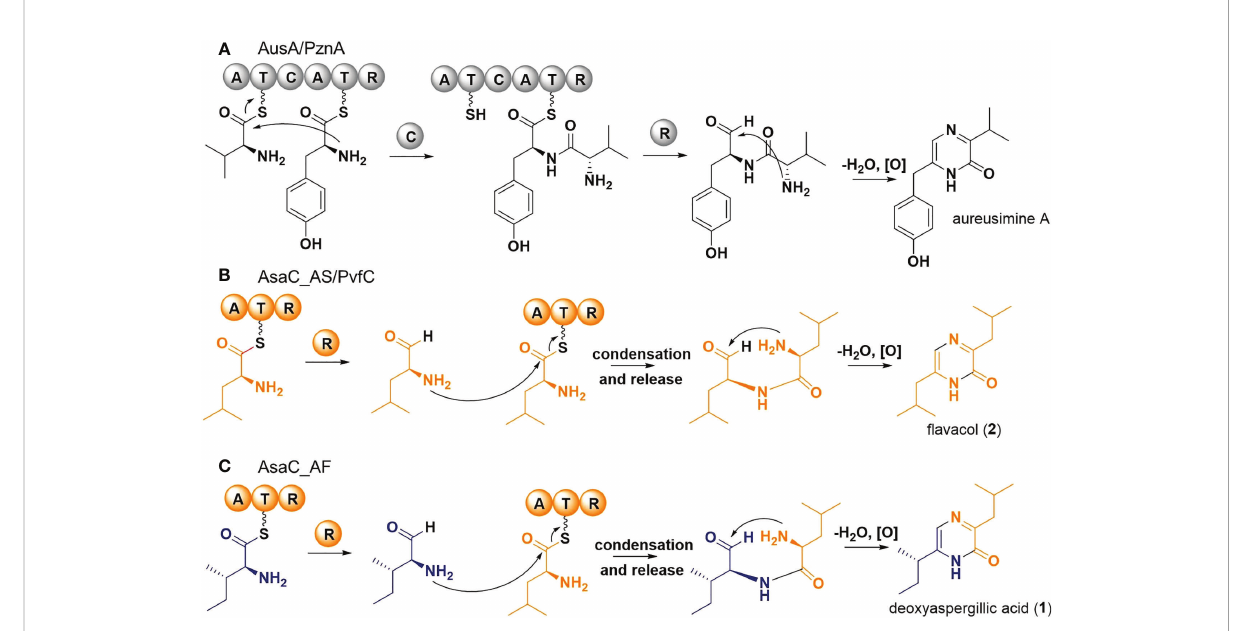
FIGURE 6 Proposed biosynthetic pathways of pyrazinone metabolites. (A) Schematic of the biosynthesis of aureusimine from valine and tyrosine by Staphylococcus aureus AusA. Adapted from (Wyatt et al., 2010; Zimmermann and Fischbach, 2010). (B) Schematic of the biosynthesis of fl avacol ( 2 ) from two leucines by PvfC in Pseudomonas fl uorescens and AsaC_AS in Aspergillus sclerotiorum . Adapted from (Morgan et al., 2021). (C) Schematic of the biosynthesis of deoxyaspergillic acid ( 1 ) from isoleucine and leucine by AsaC_AF in A fl avus